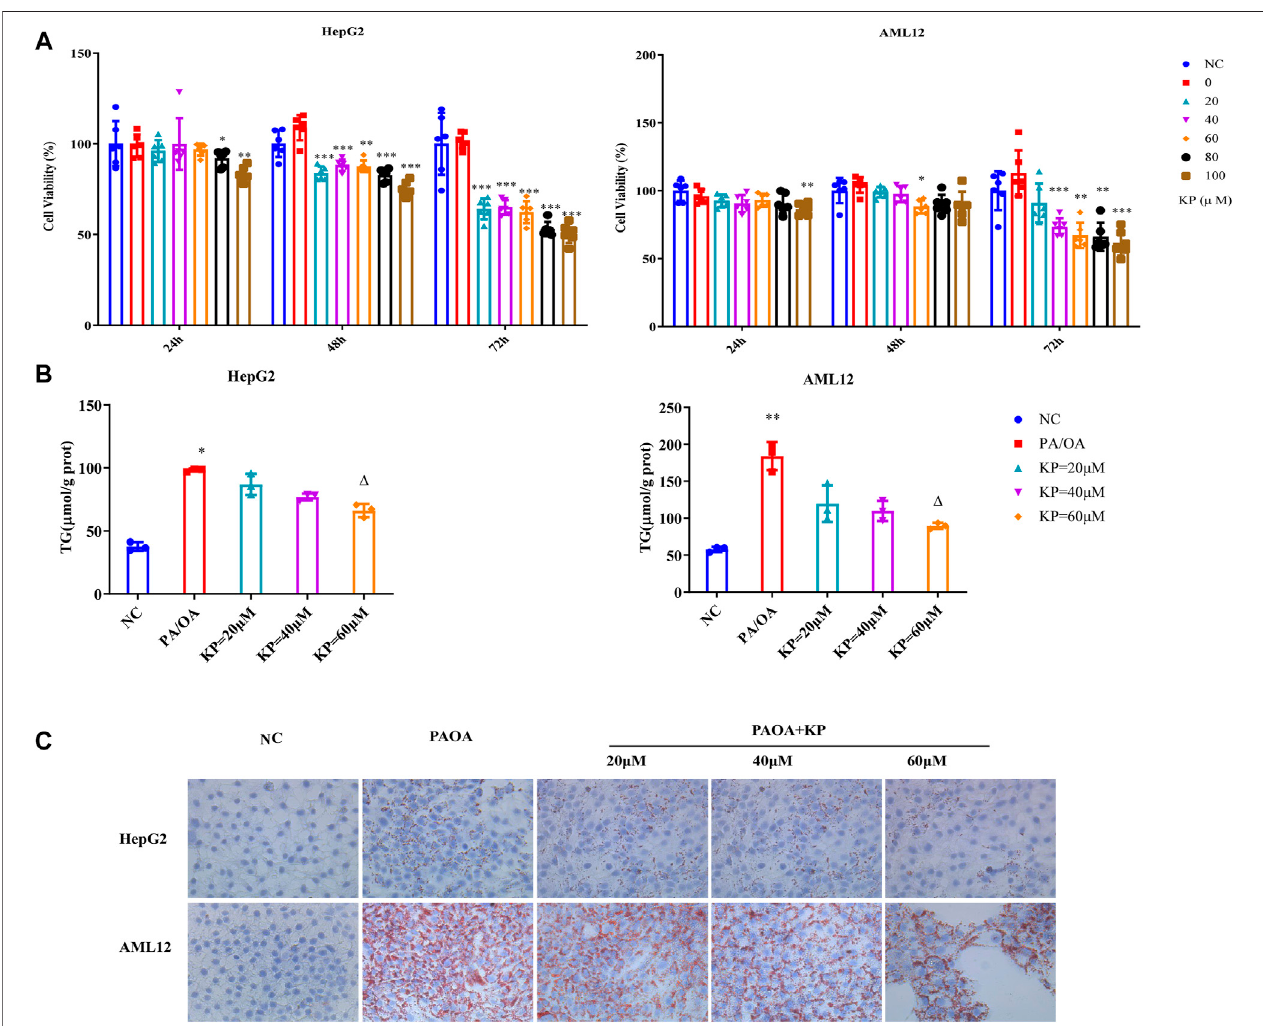
FIGURE 4 | KP reduced the deposition of lipid droplets in cells induced by PA/OA. (A) : The survival rate of HepG2 and AML12 cells after the intervention of KP in different concentration and time; (B) : The change of TG content after different concentration of KP in HepG2 and AML12 cells interfered with PA/OA (0.375/0.75 mM); (C) :TheoilredOstaininginHepG2and AML12cellsinterferedwithPA/OA(0.375/0.75 mM)and/orKPwithdifferentconcentrations( × 400).NC:Normalcontrolgroup, PA/OA: PA/OA group, KP (cid:2) 20 µM: KP low concentration group, KP (cid:2) 40 µM: KP medium concentration group, KP (cid:2) 60 µM: KP high concentration group. Compared with group NC, *, p < 0.05, **, p < 0.01, ***, p < 0.001; Compared with group PA/OA, △ , p < 0.05.